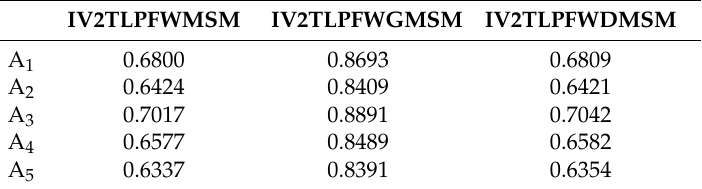
Table 3. The score functions of the green suppliers.